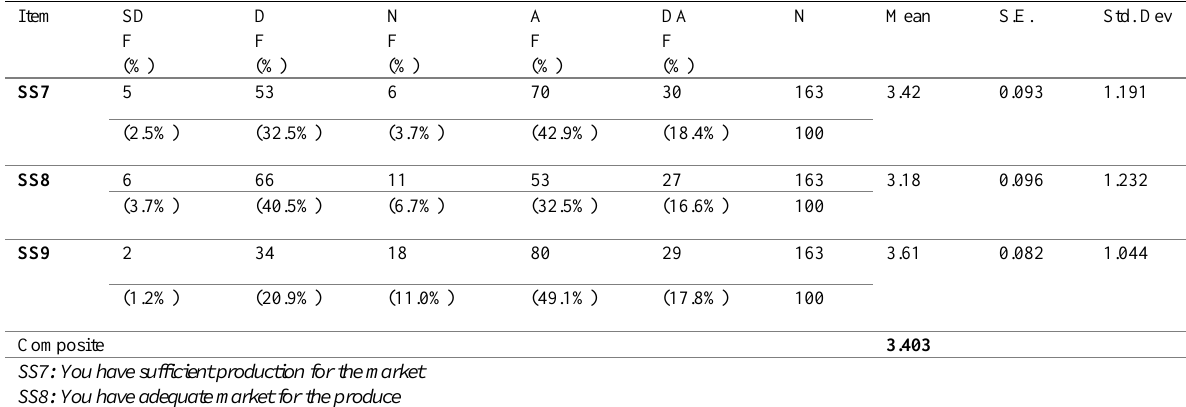
Table 3: Access to credit services and sustainability of donor funded livelihood projects